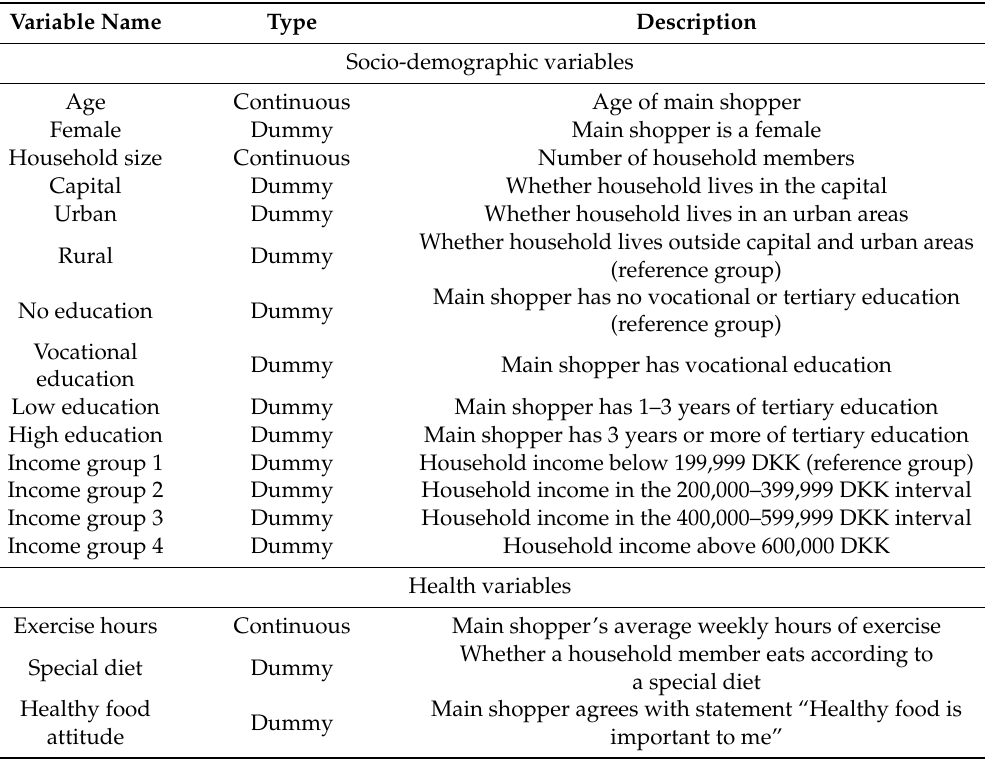
Table 3. Independent